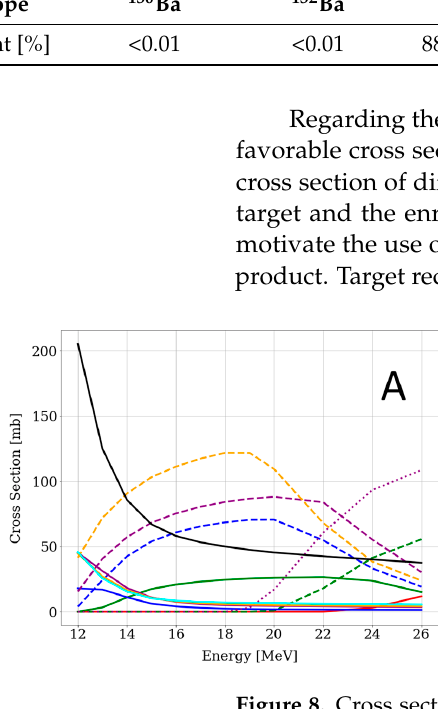
Table 2. Isotopic composition of the irradiated [ 134 Ba]BaCO 3 as specified by the supplier. Isotope